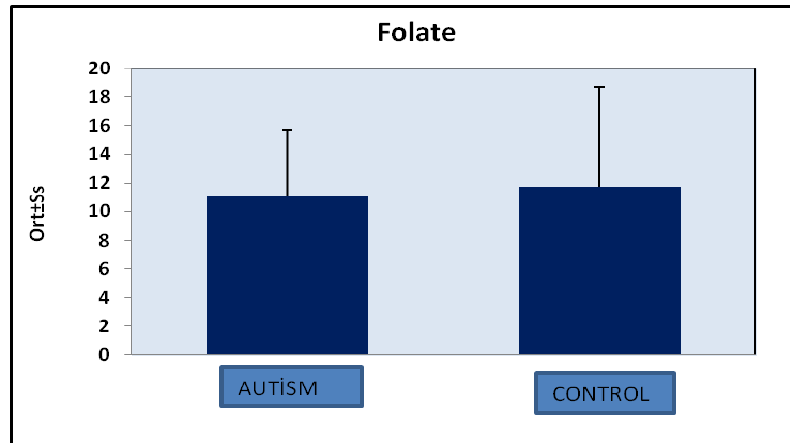
Figure 6. Distribution of Folate Measurements by Groups